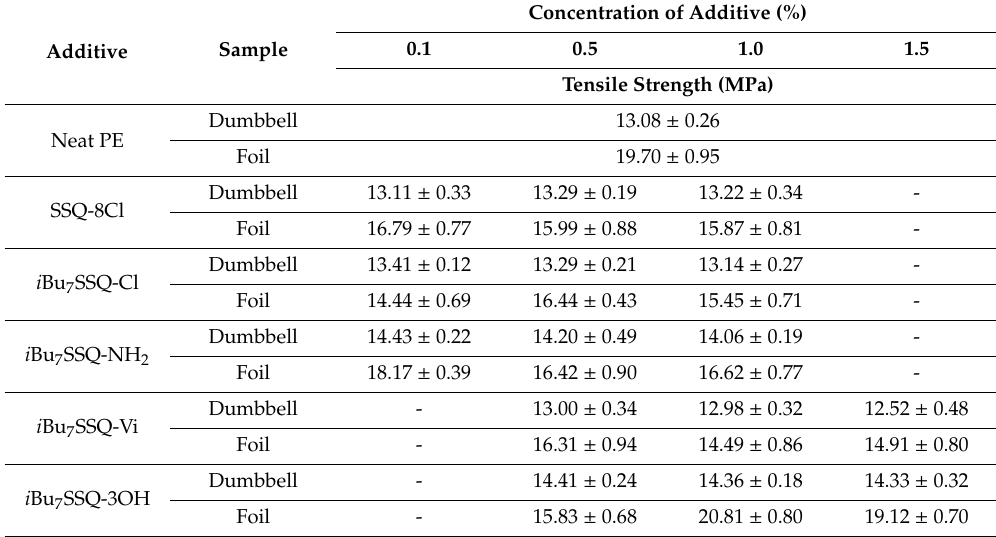
Table 1. Tensile strength of the SSQ / PE composites.